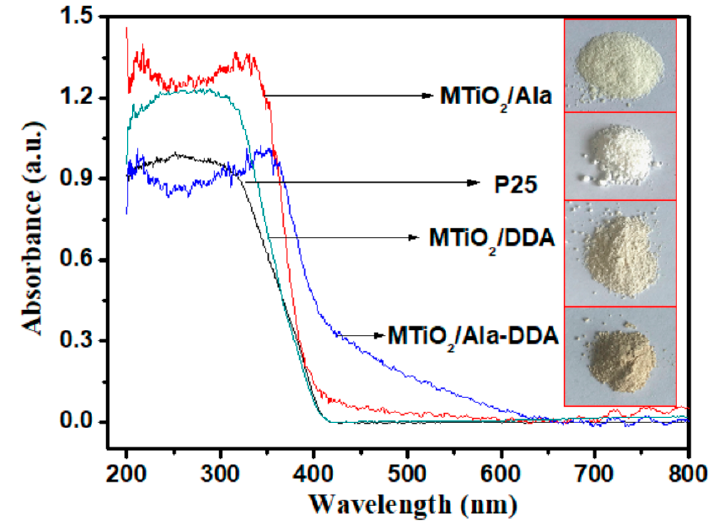
Figure 5. UV − Vis DRS spectra of P25, MTiO 2 / Ala-DDA, MTiO 2 / DDA, and MTiO 2 / Ala (inset shows digital camera photographs of samples).